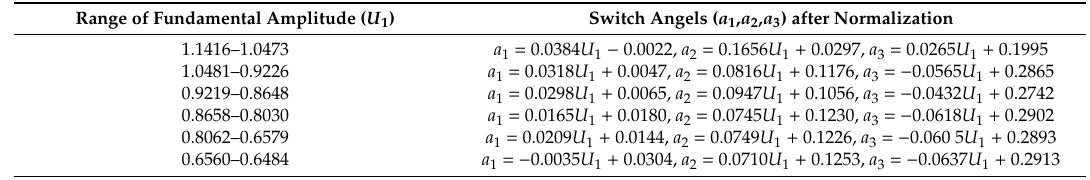
Table 6. Results of C waveband switching angles when N =